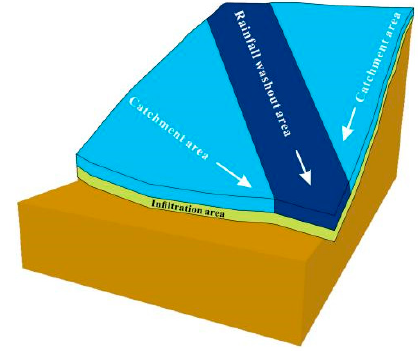
Figure 7. Fluid–structure interaction scheme.